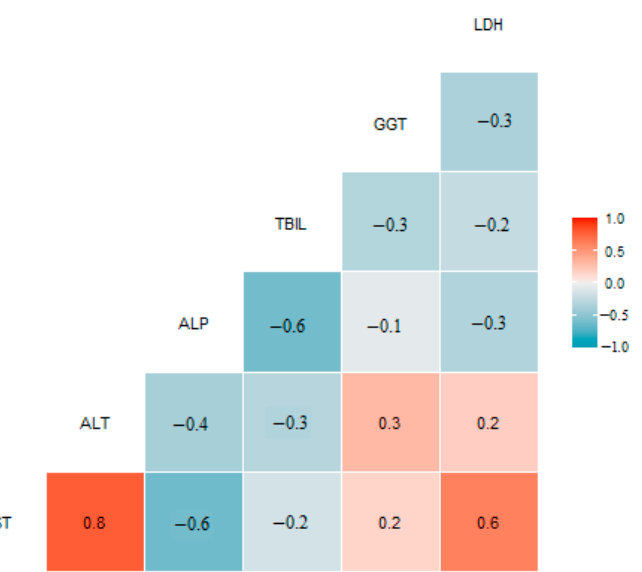
Figure 1. Correlation matrix of liver biomarkers (Pearson correlation coefficient).